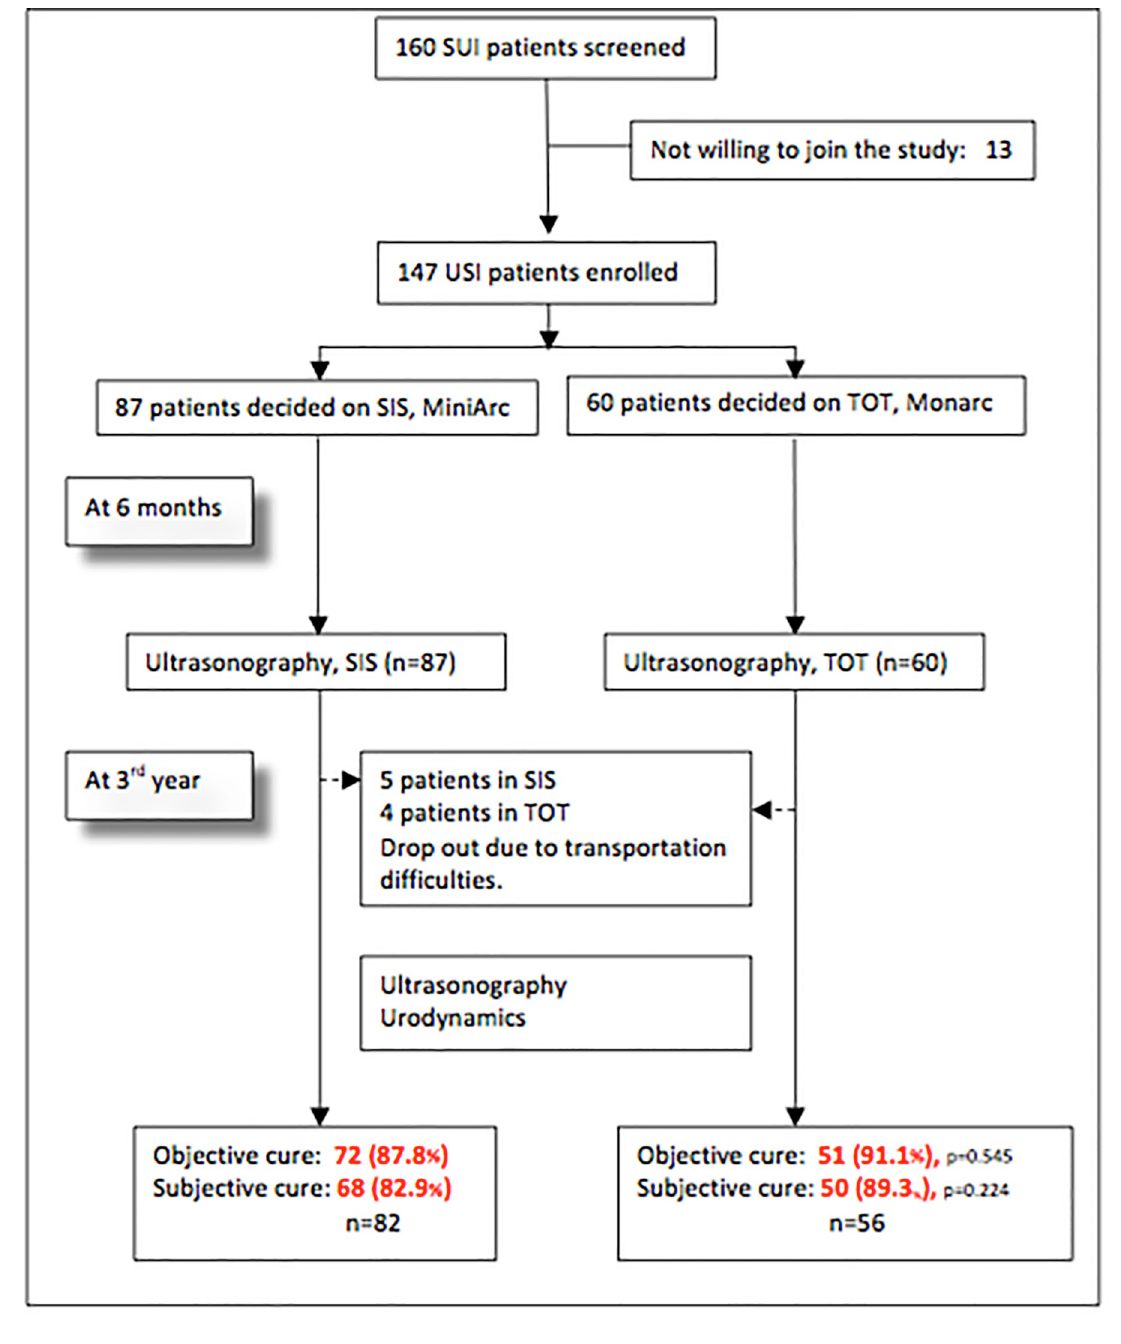
Fig 3. Flow chart of